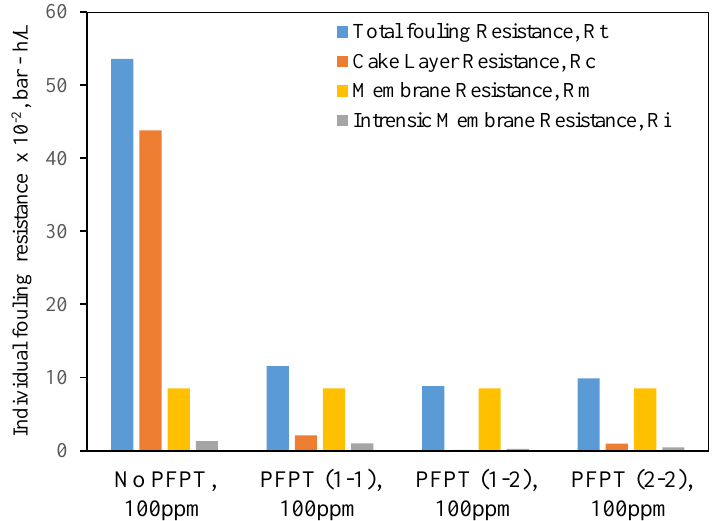
Figure 15. Individual fouling resistances for standard filtration and PFPT for a feed of 100 ppm at the TMP: 1.5 bar and CFV: 1 m/s.